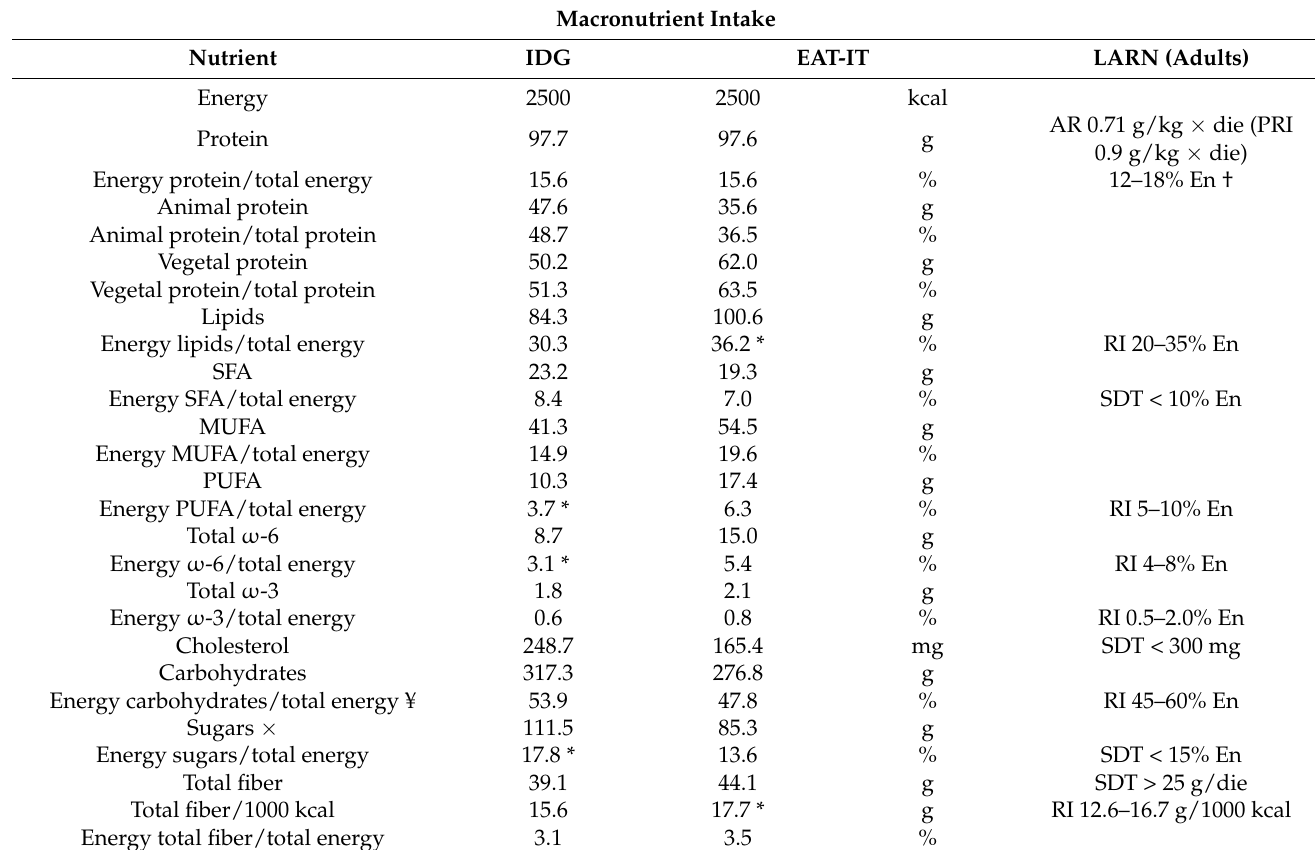
Table 4. Comparison between the macronutrients provided by the IDG and EAT-IT dietary plans for a 2500 kcal diet. Macronutrient Intake Nutrient IDG EAT-IT LARN (Adults) Energy 2500 2500 kcal Protein